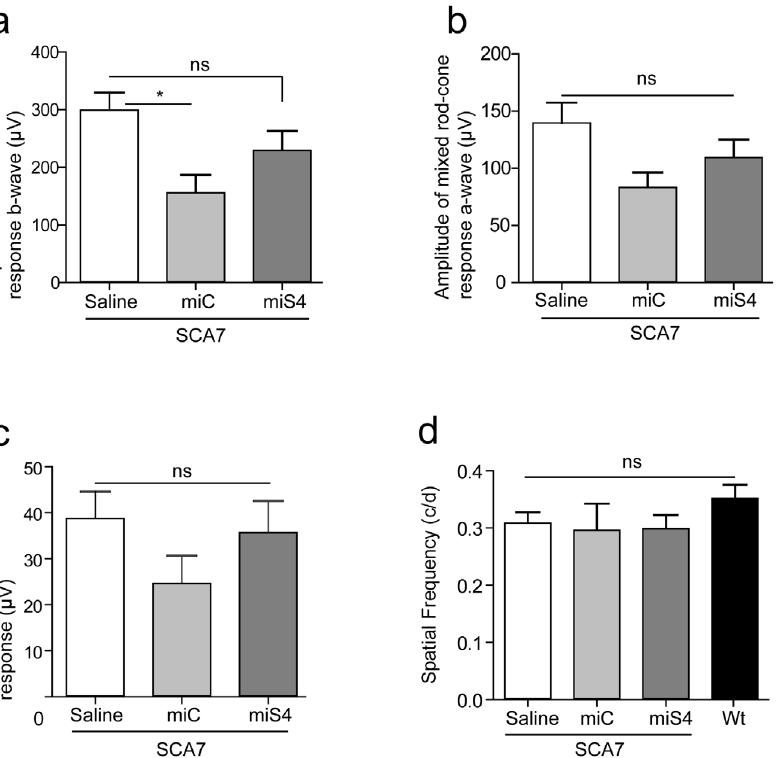
Figure 4. Retinal function 30 weeks post-injection. (a) ERG b-wave of the mixed rod-cone response, n $ 4 (b) ERG a-wave of the mixed rod-cone response, n $ 4 (c) 5 Hz flicker (cone) response, n $ 4 (d) Optokinetic response measured by the spatial frequency, n $ 3. Results are represented as mean 6 SEM, *p , 0.05.